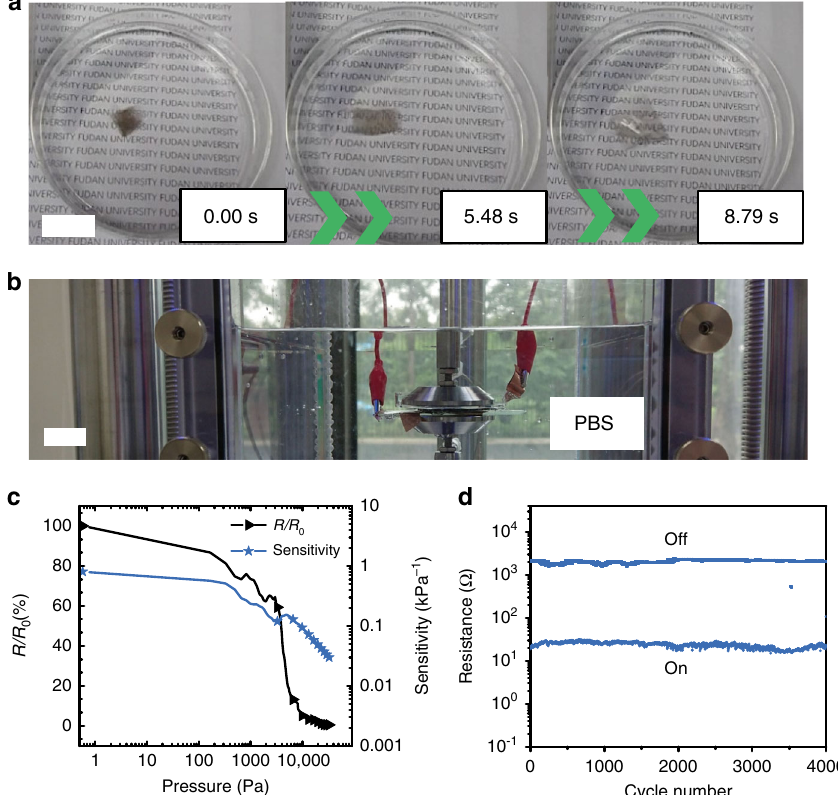
Fig. 3 Effect of immersion on the thin- fi lm sensor. a Self-unfolding in water for 9 s, scale bar: 20 mm. b Device for testing the resistance response in PBS solution, scale bar: 10 mm. c Resistance response and pressure sensitivity of the pressure sensor in PBS solution. d Resistance of the sensor over 4000 loading cycles in PBS